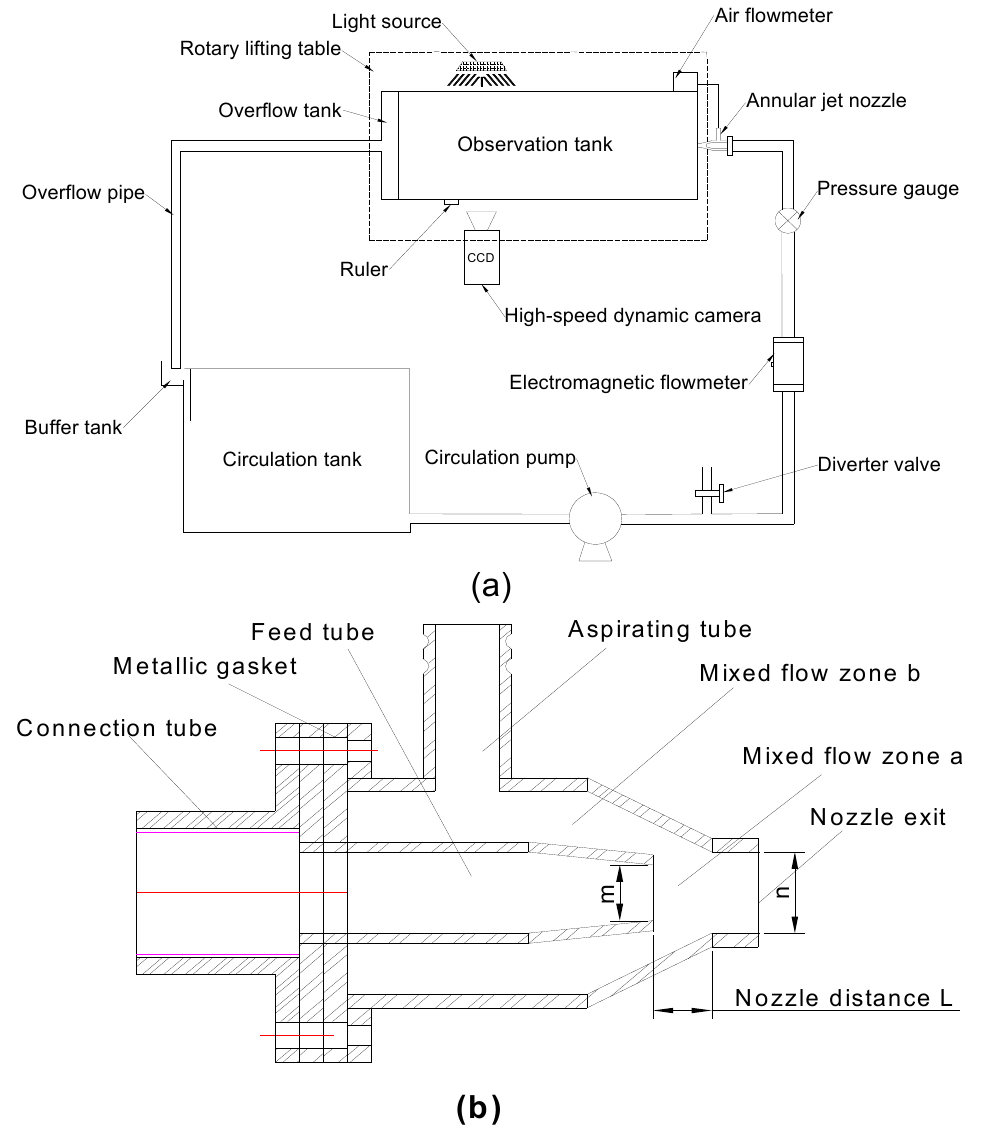
Figure 1. Experimental test system. ( a ) Diagram of test system; ( b ) structural diagram of annular jet nozzle. The inlet pressure P of the feed pipe can be adjusted by the diverter valve so that it stays at 0.10 MPa. The nozzle distance L can be adjusted by the metallic gasket and the adjustment range is 0–20 mm. The observation tank is made of highly transparent glass, which is used for submerged jet and bubble collection. The length, width, and height of the glass tank are 70 cm, 15 cm, and 40 cm, respectively. As shown in Figure 1a, the overflow tank is located at the overflow outlet end of the observation tank, with a length of 50 mm, width of 150 mm, and height of 200 mm, re- spectively, and the outlet hole diameter of the overflow tank is 32 mm. Restricted by the nozzle manufacturing process, but also to ensure the full diffusion of the submerged jet, the size of the observation tank used in this measurement is larger. In the measurement, in order to ensure that the bubble measurement does not lose focus, the matching between the brightness of the backlight and focal length is debugged, so that the outline of the bubble can be photographed well. The captured and processed sample images of bubbles are shown in Figure 2. The bubble size calibration method involves placing a steel ruler with a width of 35 mm on the inner surface of the steel tank as the standard for calibrating the bubble size. Figure 2. Captured and processed sample images of bubbles. ( a ) Original image of bubbles. ( b ) Pro- cessed image of bubbles’ contours.